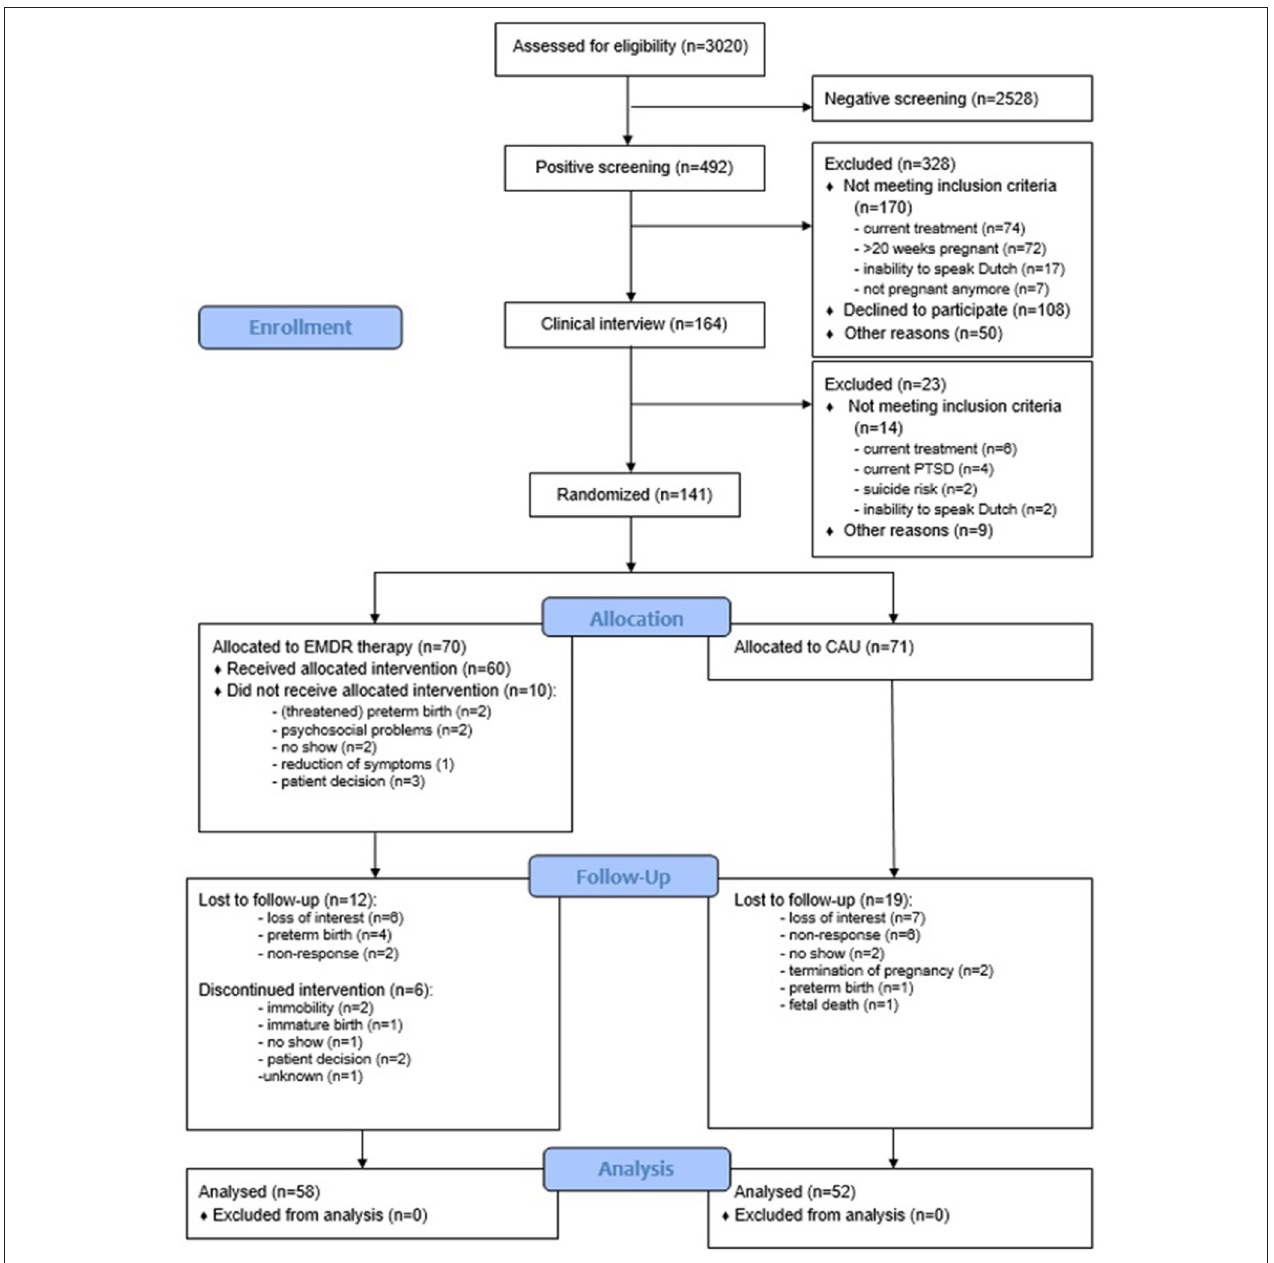
FIGURE 1 | Flow diagram. CAU, CAre-as-Usual; EMDR, Eye Movement Desensitization and Reprocessing therapy.